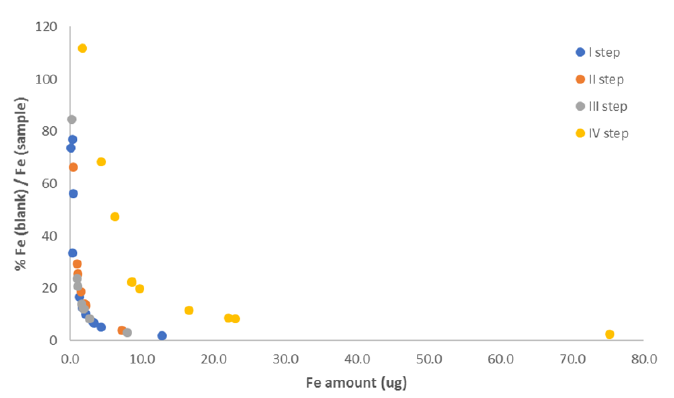
Figure 4. Blank contribution on the results from selective leaching experiments as a function of the Fe